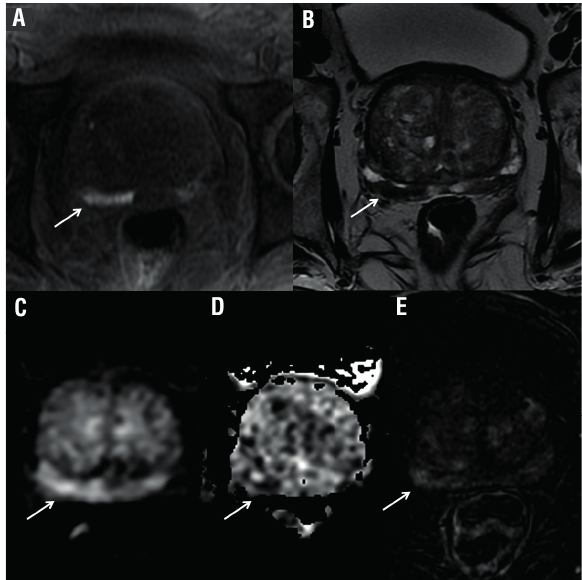
Figure 2 - MpMRI showing suspected lesion on T1WI (a), T2WI (b), DWI (c), ADC map (d) and perfusion (e) sequences. The radiologist 1 identifi ed lesion in the prostate right middle third and assigned as PI-RADS 5 with extra-prostatic extension. The same lesion was scored as 2 for the radiologist 2. The pathological analysis diagnosed a Gleason 6 in the right middle third. The patient was classifi ed as having signifi cant cancer due to PSA of 10ng/ mL. In this case, the presence of blood may have limited the interpretation of the reader